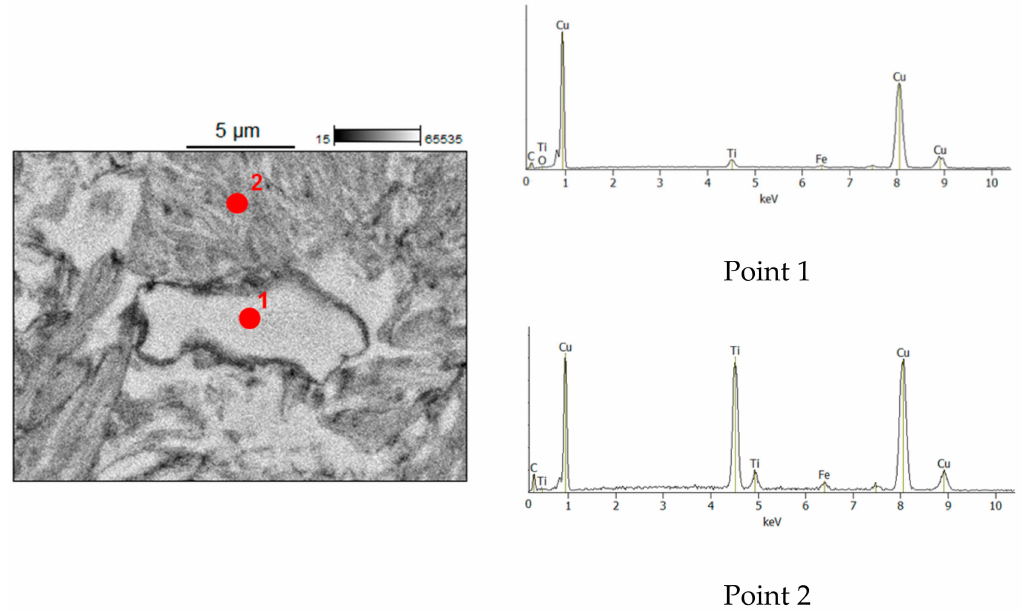
Figure 5. Energy Dispersive Spectroscopy (EDS) analysis of the TiC–Cu composite obtained by SPS of the ball-milled mixture of Ti 25 Cu 75 and carbon